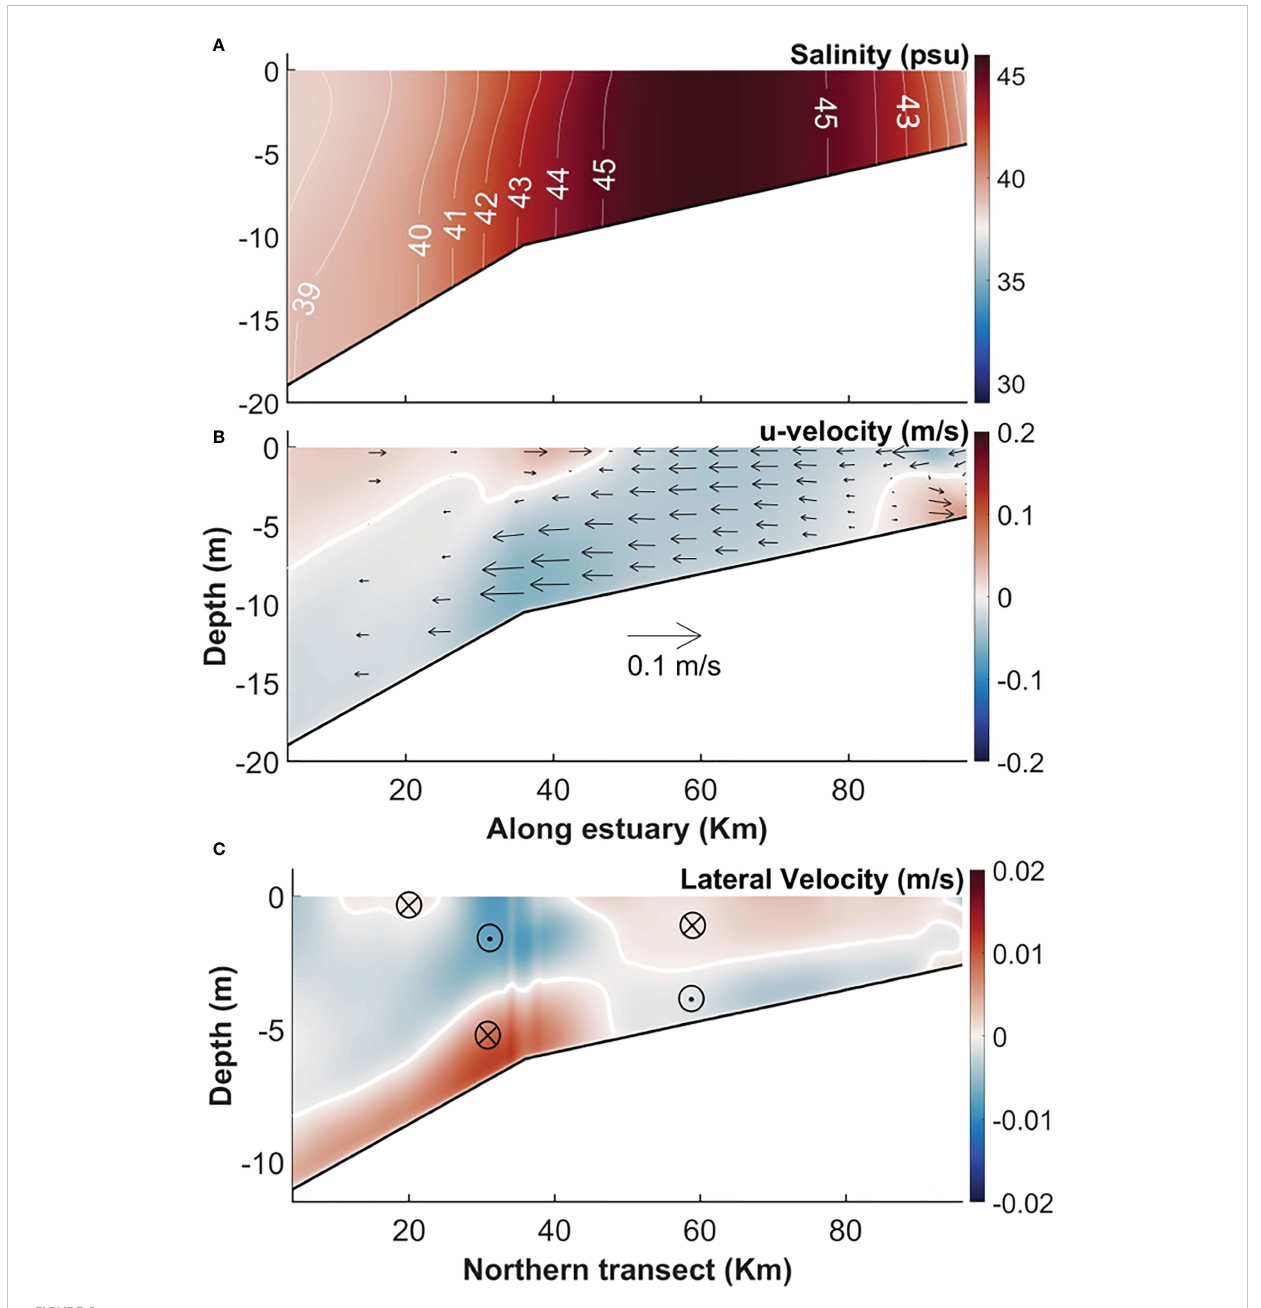
FIGURE 8 Along-channel pro fi les of time-averaged (A) salinity and (B) axial velocity along the main axis and (C) lateral velocities along the northern transect in